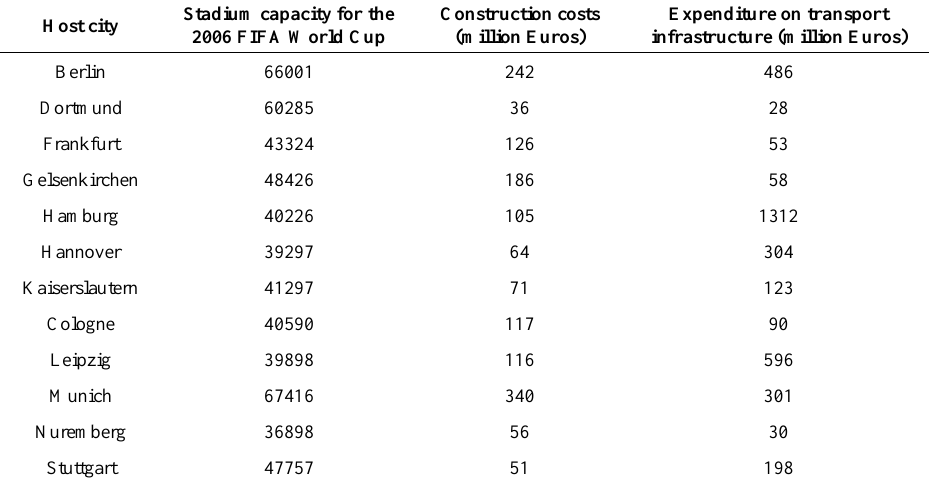
Table 1. Construction Costs and Expenditure on Transport Infrastructure.